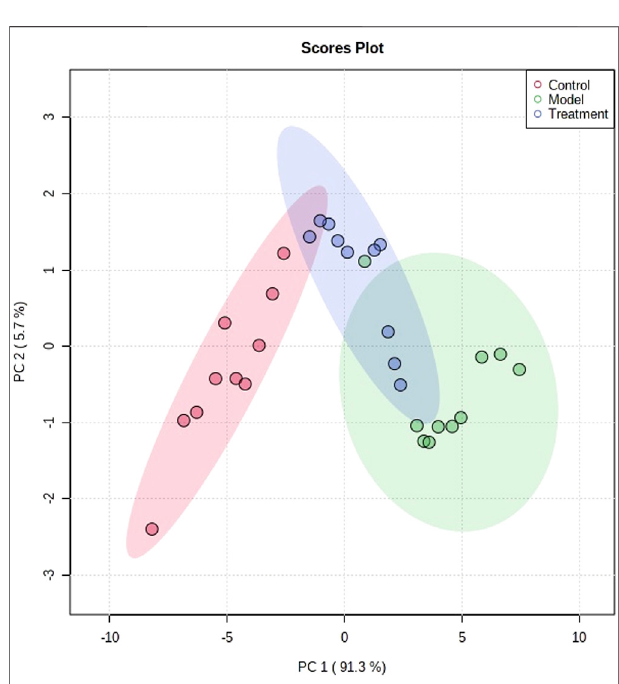
FIGURE 6 | PCA score plots of multivariate data analysis.